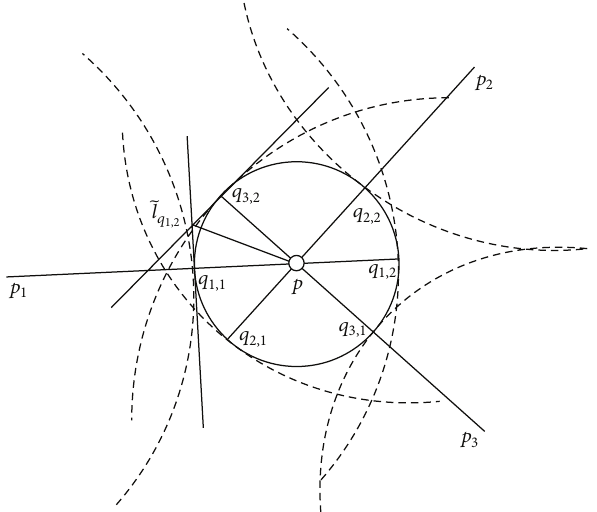
Figure 3: Analysis of localization